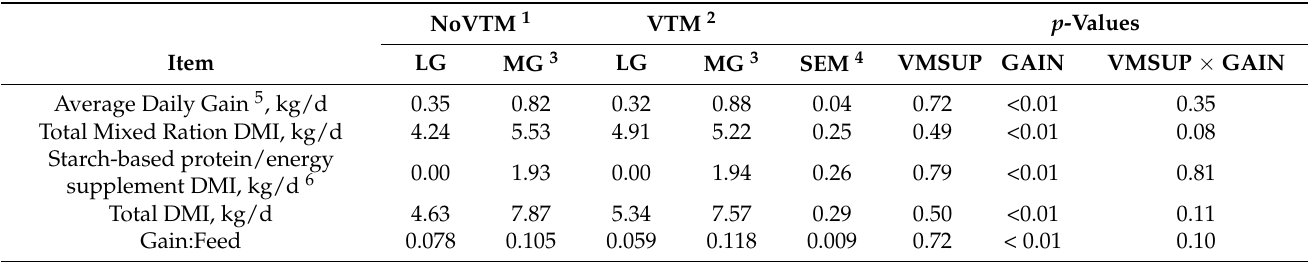
Table 4. Performance and dry matter intake (DMI) of beef heifers during the first trimester of gestation as influenced by vitamin and mineral supplementation [VMSUP; not supplemented (NoVTM) or supplemented (VTM)] and two different rates of gain [GAIN; low rate, 0.28 kg/d (LG) or moderate rate, 0.79 kg/d